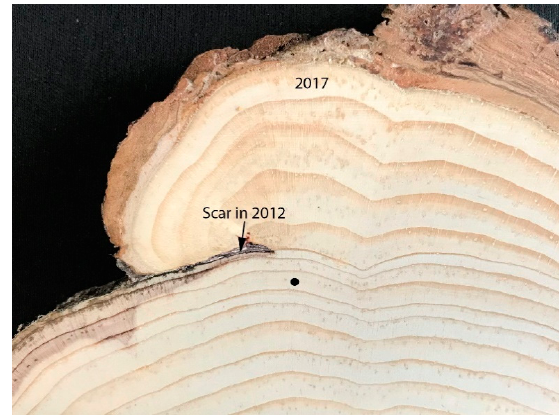
Figure 5. Cross section of a Pinus hartwegii stem wedge injured by the 2012 lahar event. The injury is located in late latewood, which allows dating of the event to August